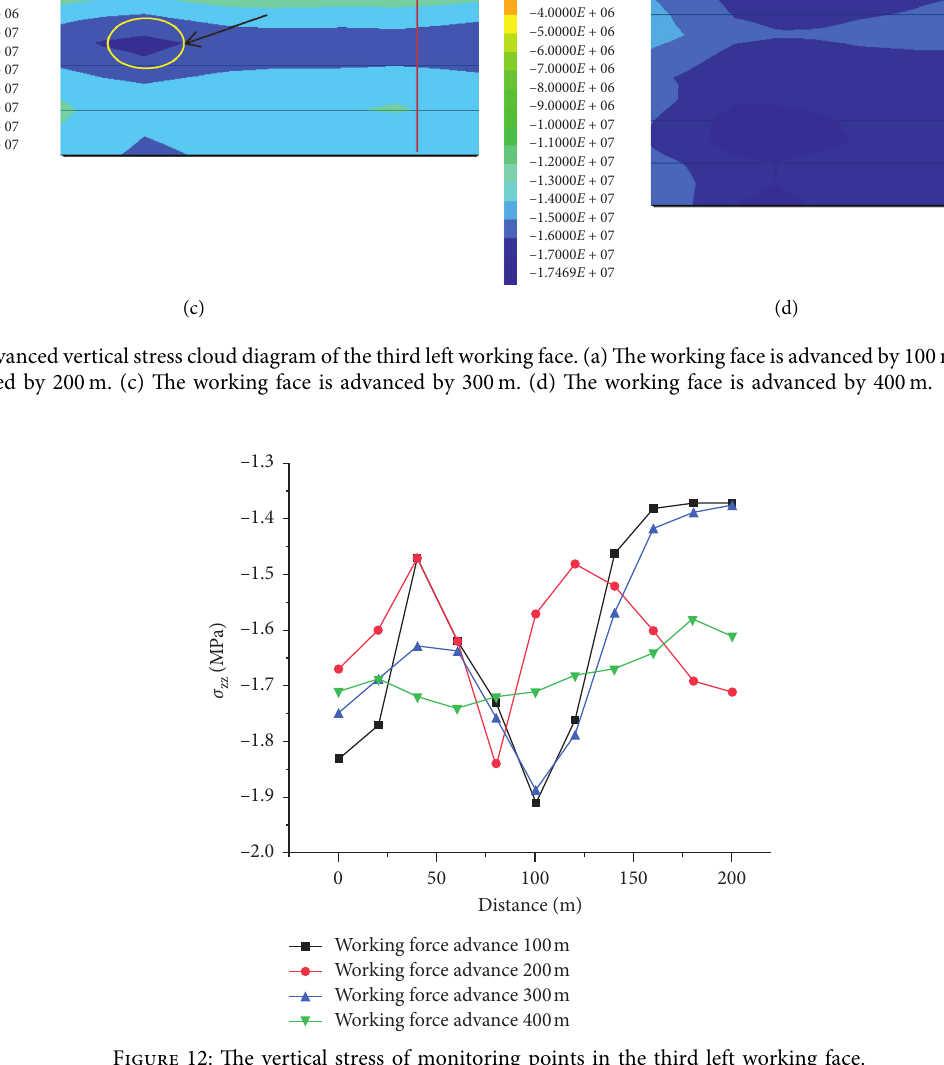
Contour of XX–stress Calculated by: volumetric